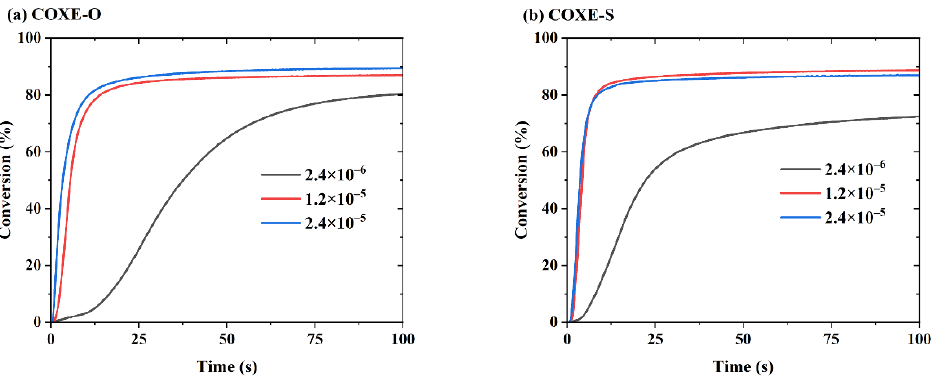
Figure 8. C=C double bond conversion curves measured for TPGDA polymerization initi- ated by ( a ) COXE-O and ( b ) COXE-S at different concentrations (2.4 × 10 − 6 , 1.2 × 10 − 5 and 2.4 × 10 − 5 mol · g − 1 , respectively) under 425 nm LED irradiation (photo intensity: 100 mW · cm − 2 ).